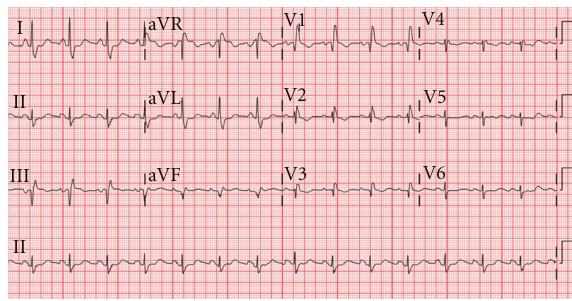
Figure 1: Patient’s baseline electrocardiogram.